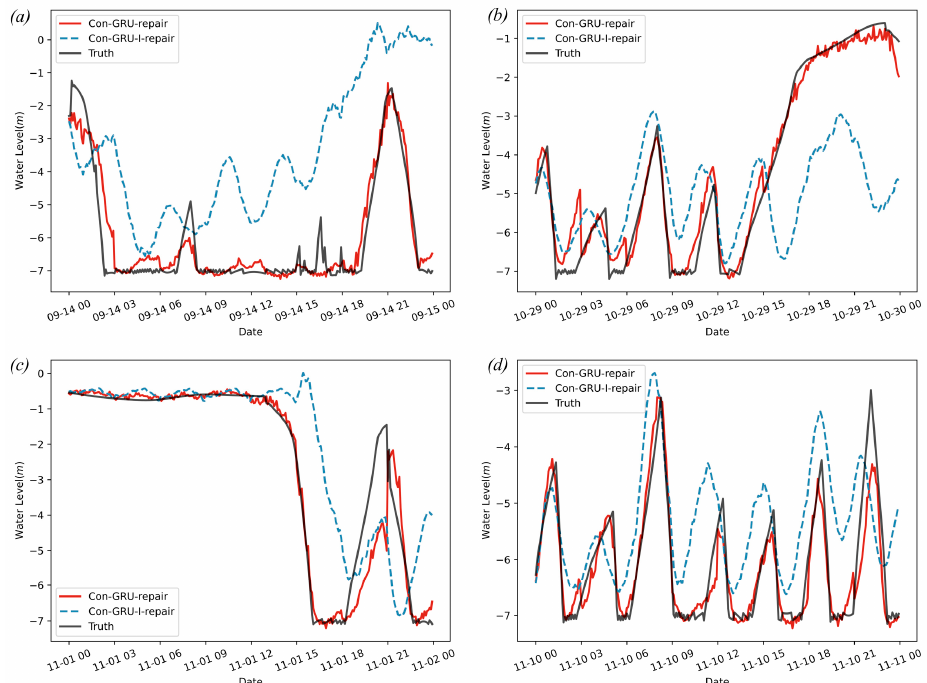
Figure 12. Comparison of the Con-GRU model and Con-GRU-I model in iterative repair on test dataset: ( a ) results of data repair on 14 September 2020; ( b ) results of data repair on 29 October 2020; ( c ) results of data repair on 1 November 2020; ( d ) results of data repair on 10 November 2020.